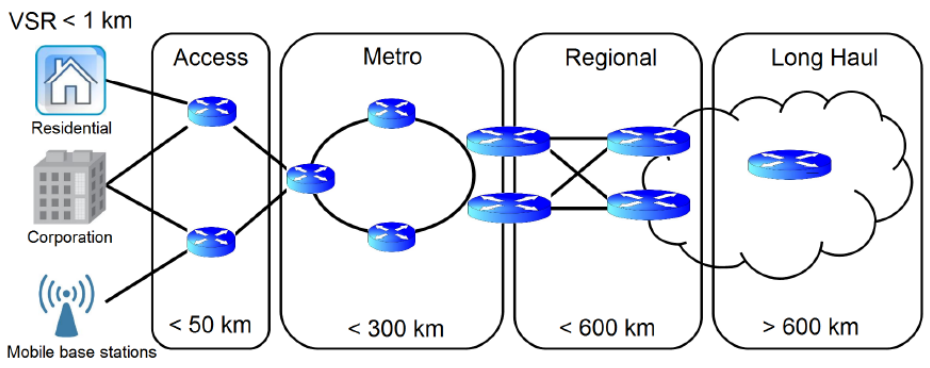
Figure 2. Examples of optical network topology and transmission reach, servicing data centers, access, metro, and long-haul links.